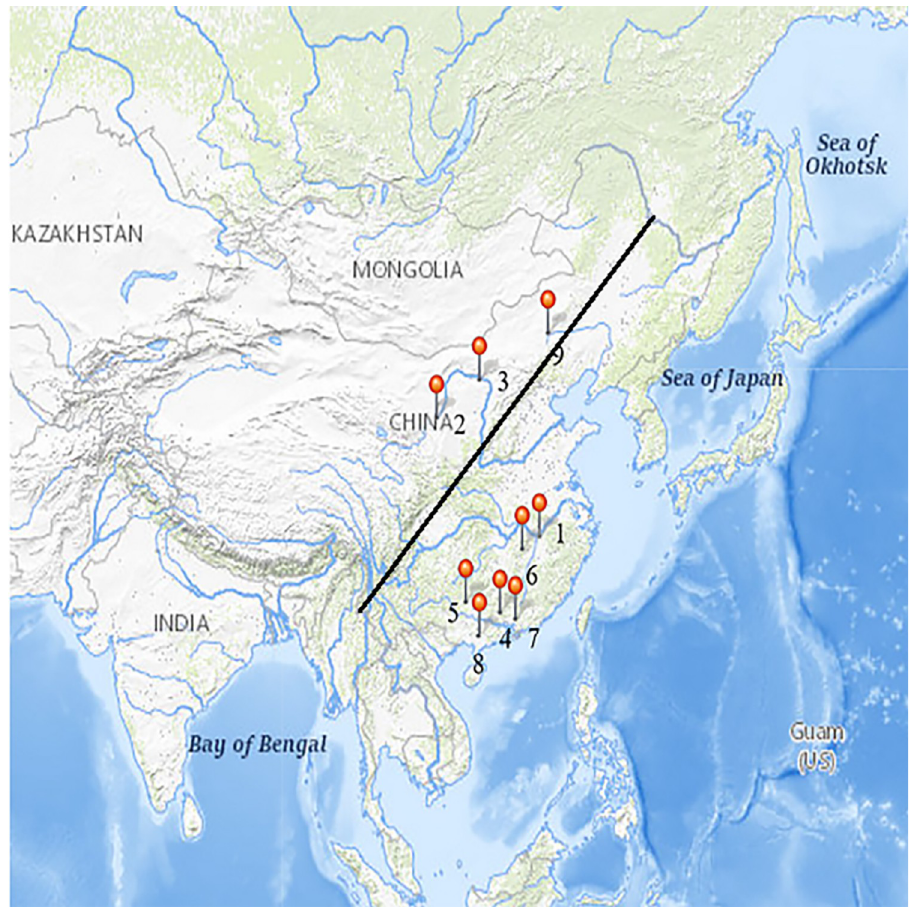
Fig 1. The sampling sites used in this study. Note. The black line on the map represents the “Aihui-Tengchong Line”. The stars indicate different sampling locations and the numbers in the upper right corner are sorted by sampling time. Sampling locations: 1. Poyang Lake, Jiangxi Province (28˚N, 116˚E). 2. Ningxia Hui Autonomous Region (37˚N, 105˚E). 3. Honghaizi Wetland Park, Inner Mongolia;/ Ordos City, Inner Mongolia (39˚N, 109˚E). 4. Zhaoqing, Guangdong Province (23˚N, 112˚E). 5. Nanning, Guangxi Province (22˚N, 108˚E). 6. Suichuan, Jiangxi Province (26˚N, 114˚E). 7. Shenzhen, Guangdong Province (22˚N, 114˚E). 8. Zhanjiang, Guangdong Province (21˚N, 109˚E). 9. Dali Lake, Inner Mongolia(42˚N,